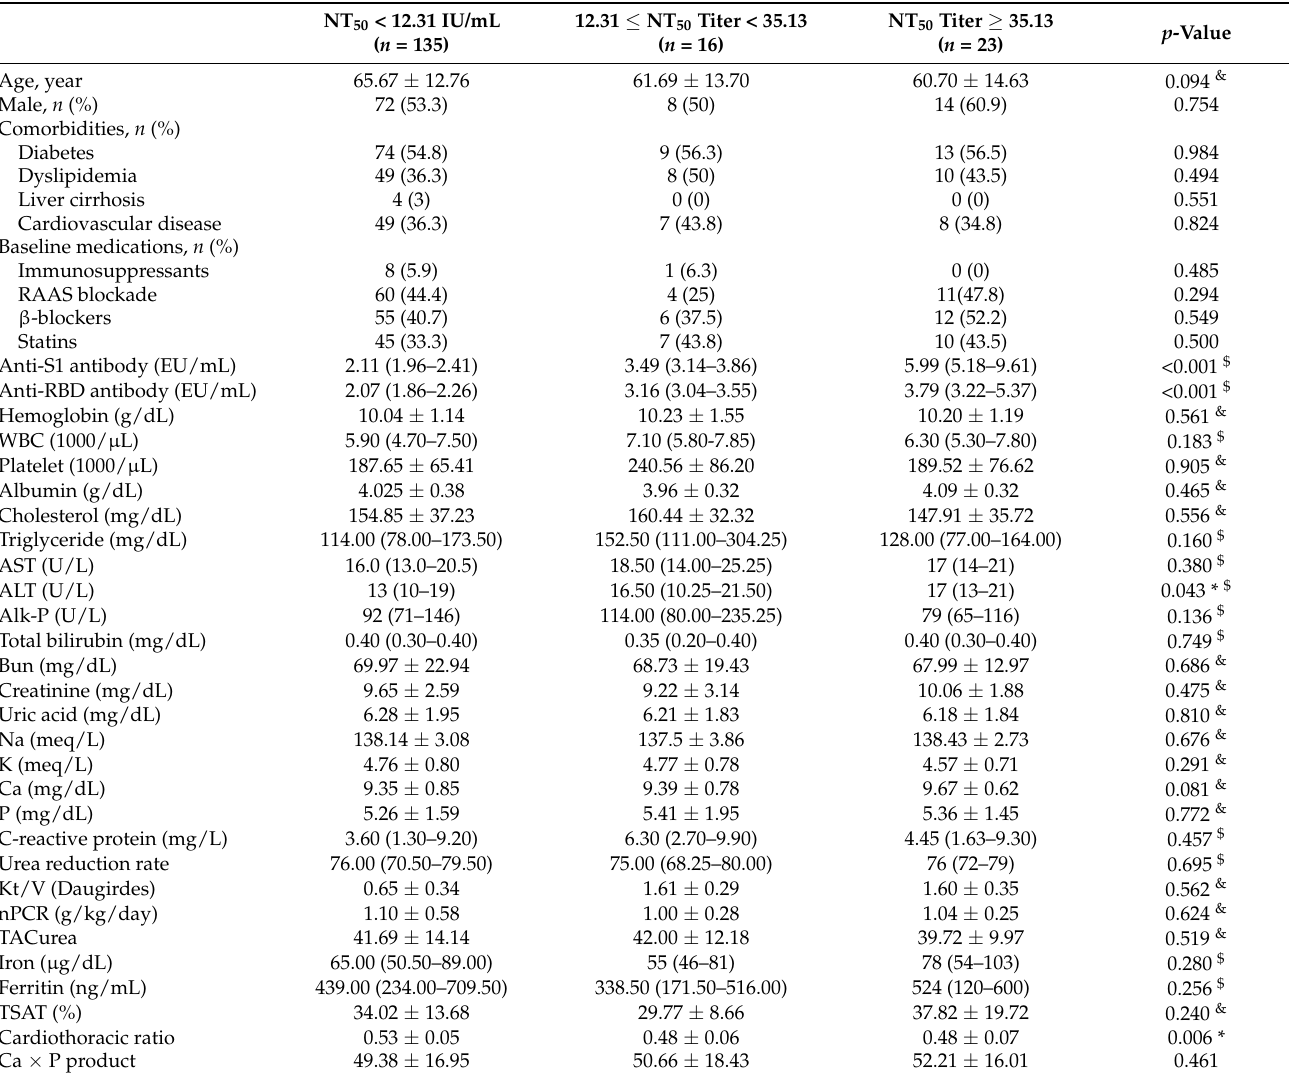
Table 1. Baseline characteristics of patients receiving a single dose of ChAdOx1 vaccine, stratified by NT 50